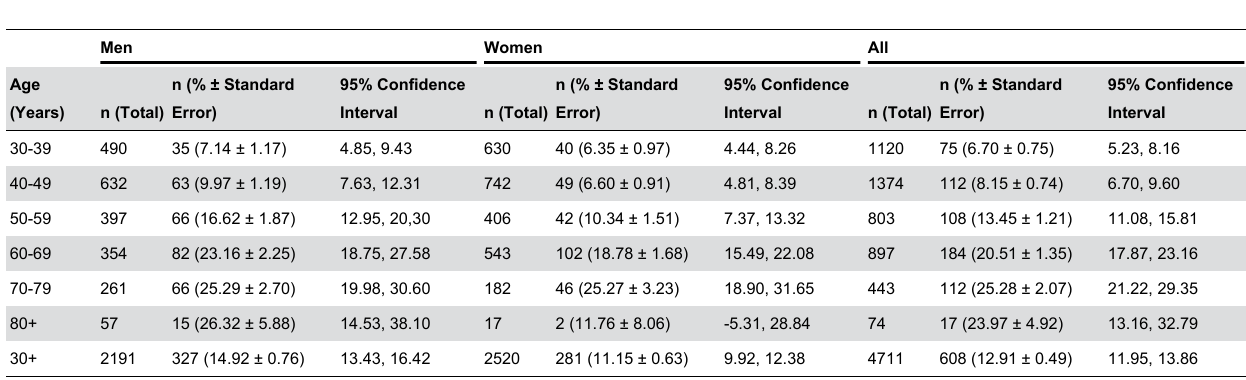
Table 1. Prevalence rates of pterygium in the population of the central India Eye and Medical Study stratified by age and